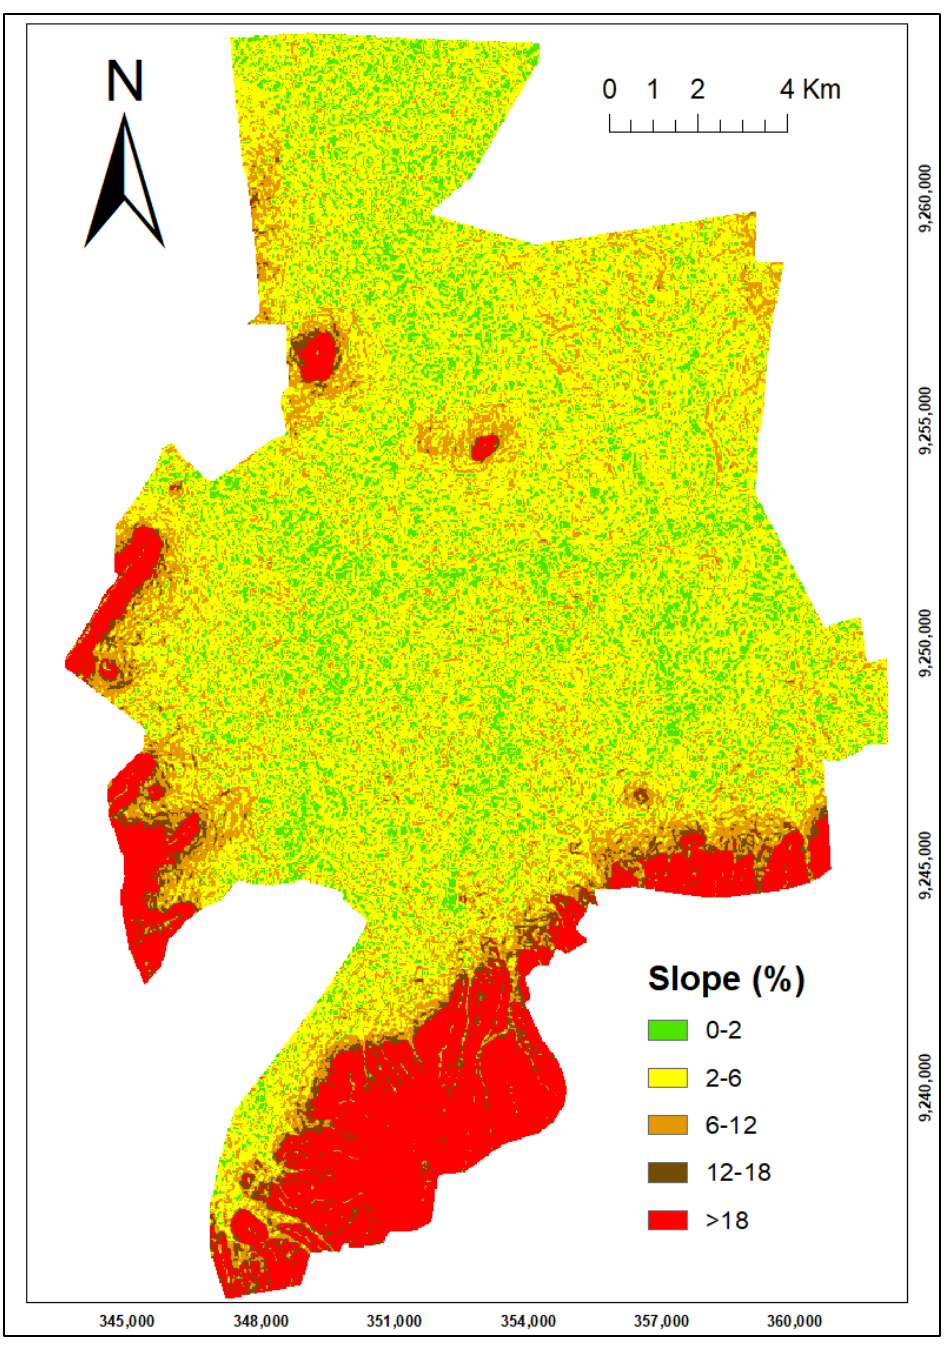
Figure 8. Topographical map.